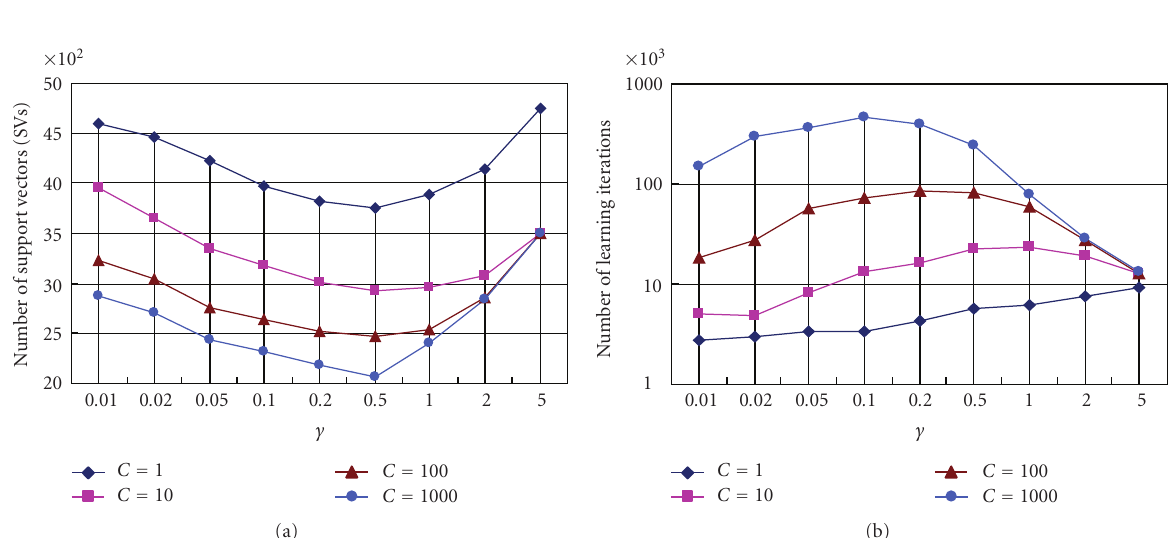
Figure 8: (a) Number of SVs versus γ ; (b) Number of learning iterations versus γ (model Meng versus Others parameterized with C